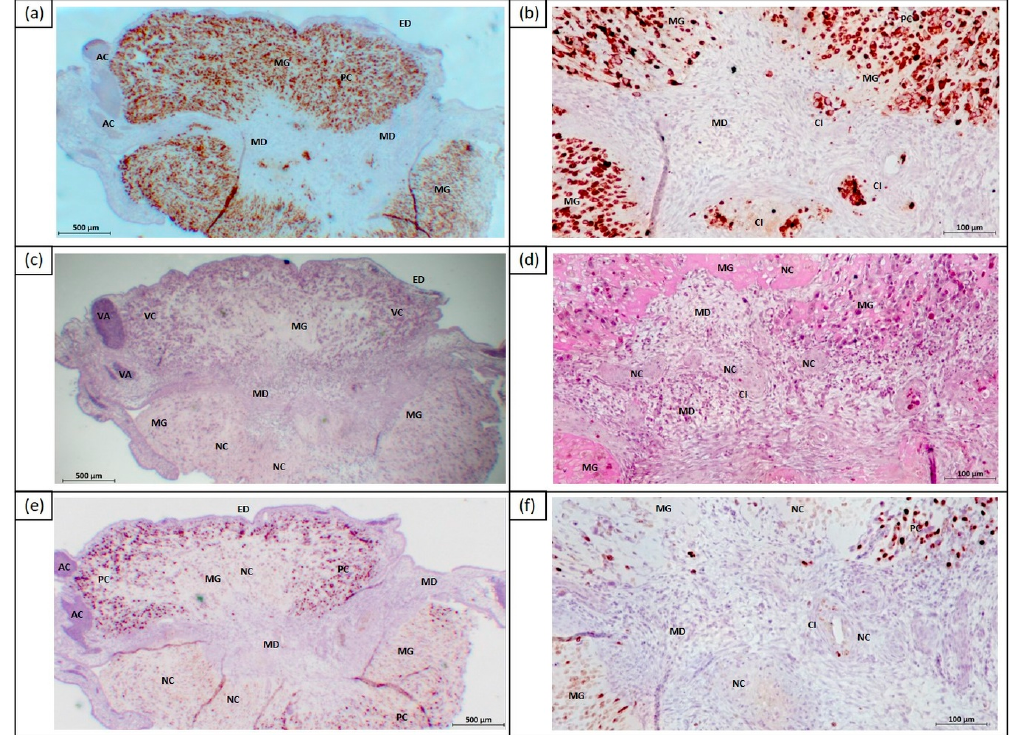
Figure 6. IHC stains of human 92.1 UM cells in the CAM at E16 following intratumoral ECT using 2.5µg/mL bleomycin and eight pulses 750V/cm pulse strength. ( a ) Overview of CAM including human UM cells 92.1 were immunohistochemically stained with antihuman melanosome marker (in brown); ( b ) central CAM section with surrounding Matrigel graft and central invading human 92.1 cells were immunohistochemically stained with antihuman melanosome marker (in brown); ( c ) overview of CAM including human UM cells, viability of human UM cells were controlled using hematoxylin and eosin staining (HE staining); ( d ) PAS staining of central CAM section; the majority of invading 92.1 cells were necrotic (negative for hematoxylin); ( e ) overview of CAM including human UM cells; proliferating 92.1 were immunohistochemically labeled with antihuman Ki67 marker (in brown); ( f ) Ki67 labeling of central CAM section (in brown), peripheral proliferating cells, central Ki67 negative cells. Abbreviation: AC = apoptotic cells, CI = cancer cell invasion, ED = Chorionic ectoderm, MD = chorionic mesoderm, MG = Matrigel graft, NC = necrotic cells, PC = proliferating cells, VA = vascularization, VC = vital cells. Scale bars = 500 µm ( a , c , e ), = 100 µm ( b , d , f ). Compared to ECT, in the control group samples without treatment or chemotherapy alone, no significant effect on the viability of tumor cells in Matrigel grafts could be detected (Figure 7).